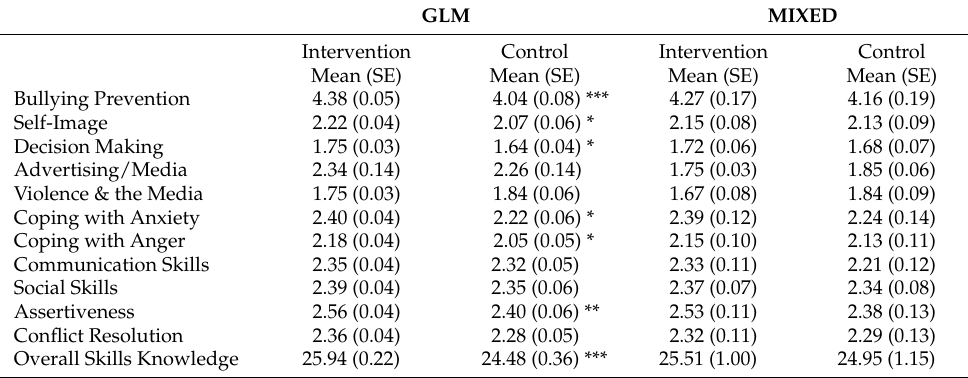
Table 6. Adjusted Means at Post-Test for Skills Knowledge Variables by Condition, GLM and MIXED